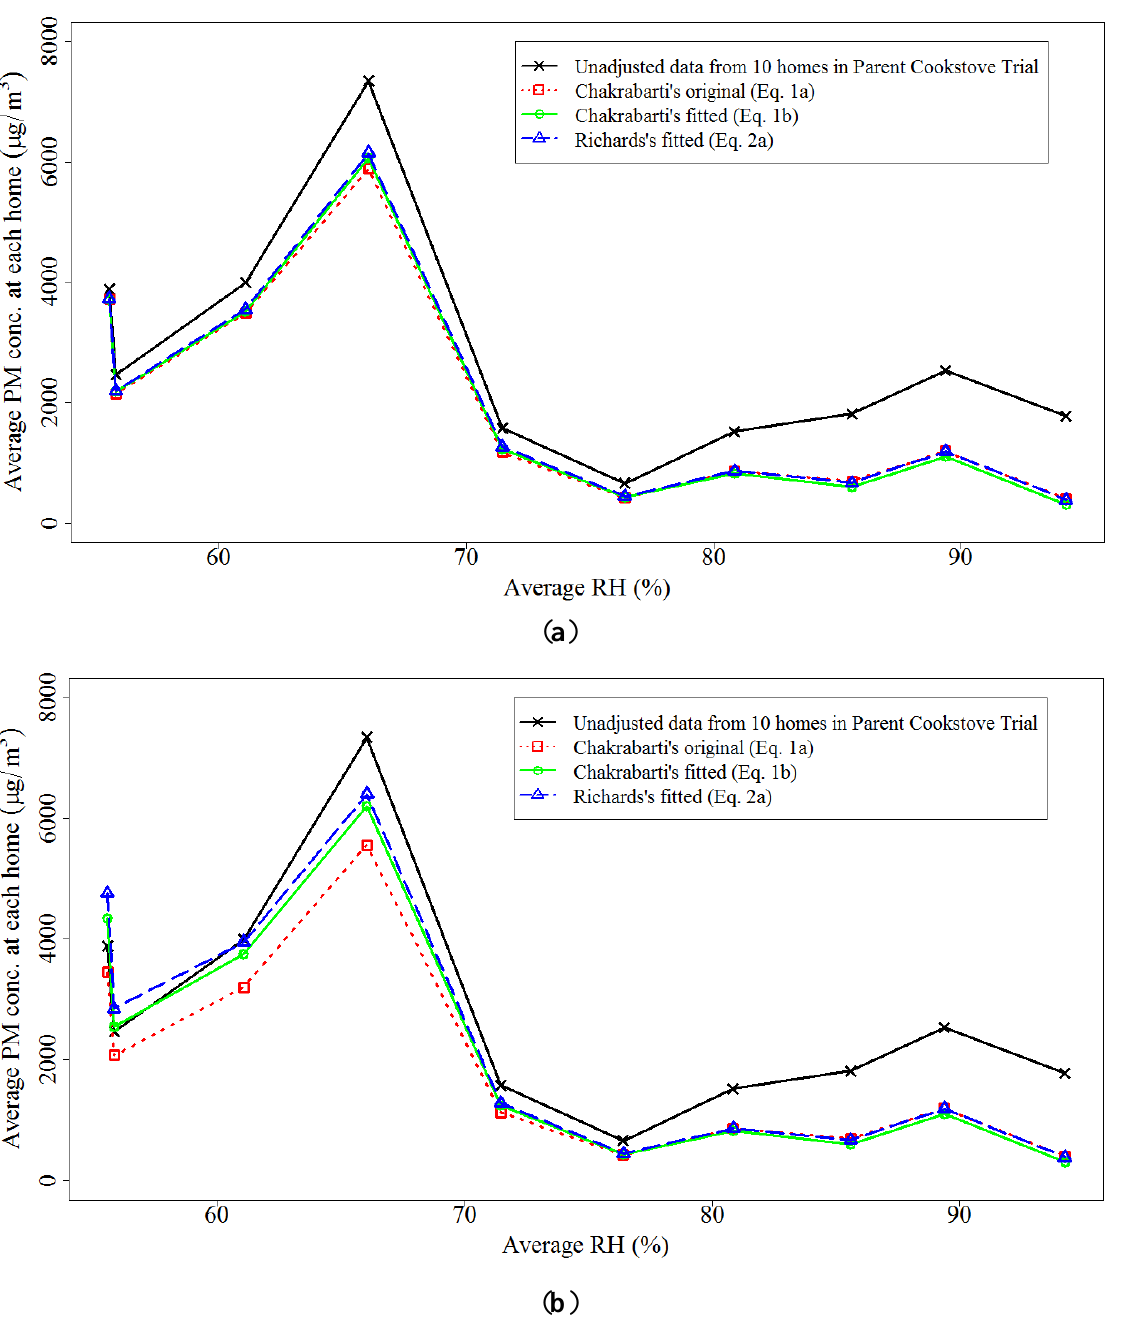
Figure 2. Average PM concentrations of 10 homes adjusted with three humidity adjustment equations ( a ) with a RH threshold and ( b ) without a RH